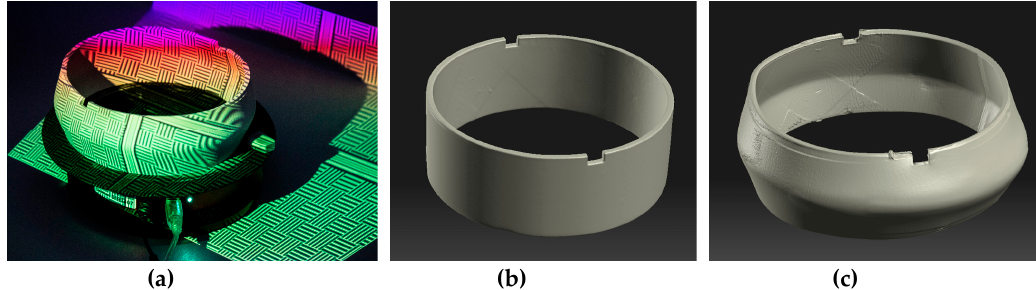
Figure 14. 3D-scanning of burst containments (a) including results before (b) and after (c) burst.